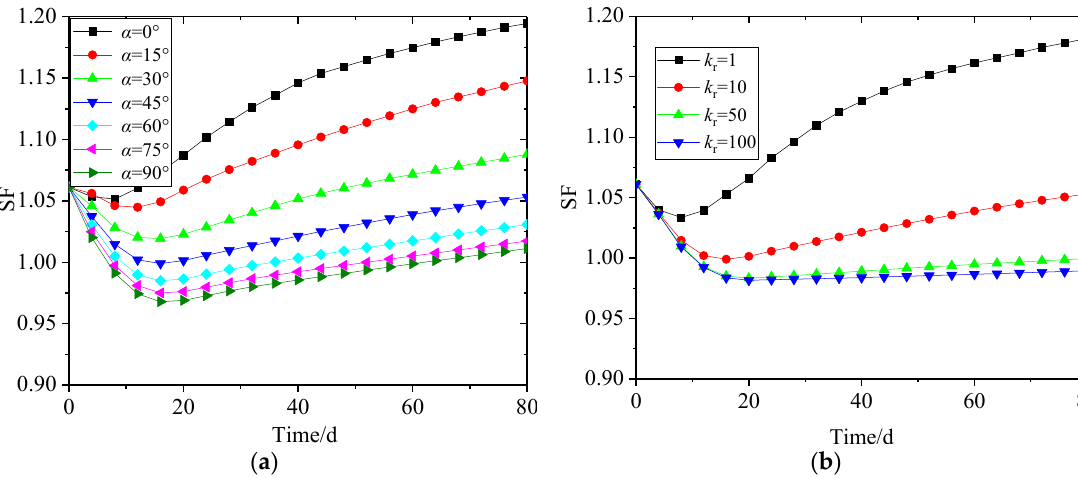
Figure 11. Safety factors (SFs) of sandy slope under di ff erent k r and α values. ( a ) k r = 10. ( b ) α = 45 ◦ .